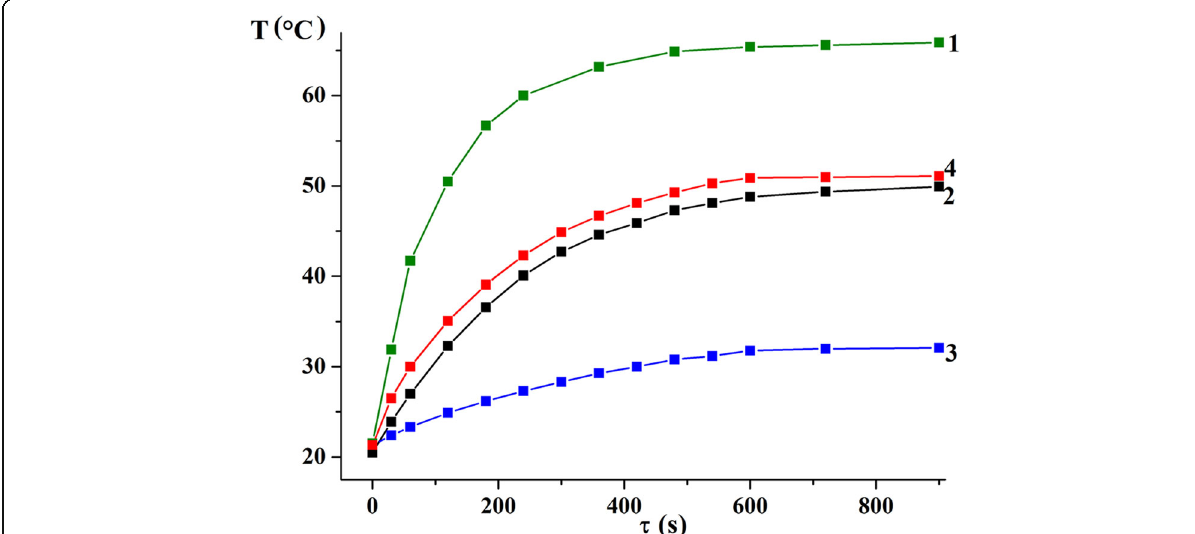
Fig. 4 Dependences of heating temperature vs time for nanoparticles synthesized via sol-gel method (1), by precipitation from DEG solution (2), and by precipitation from reversal microemulsions based on Triton X-100 (3) and CTAB